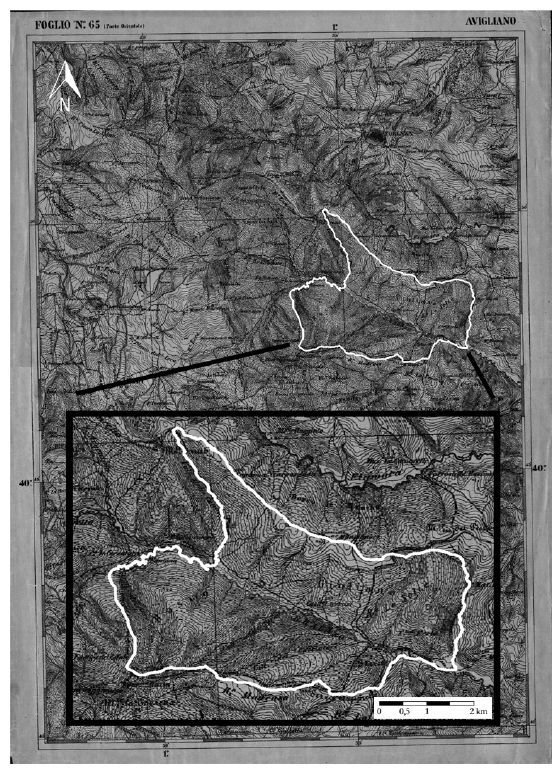
Figure 3. Historical map of the Municipality of Forenza (1876).